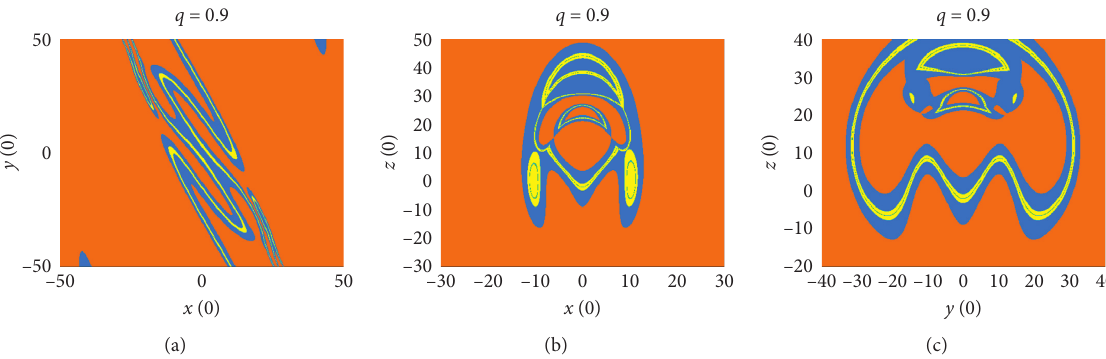
Figure 12: Panorama of the basin of attraction of system (1) with q � 0.9: (a) x (0) − y (0) plane, (b) x (0) − z (0) plane, and (c) y (0) − z (0) plane.